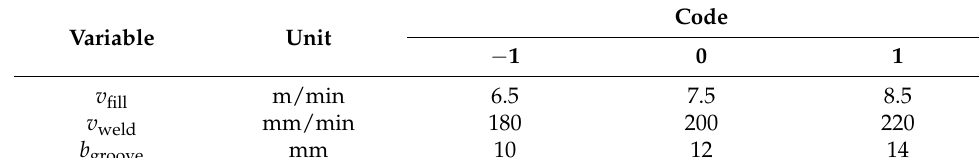
Table 3. Ranges of the parameters used in the Box–Behnken design. Table 5. Pulse parameters and oscillation parameters set in the machines.